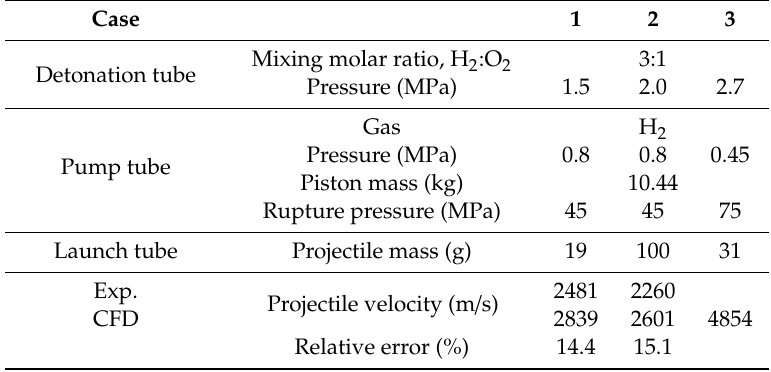
Table 1. Operating conditions in the experiments and simulation.